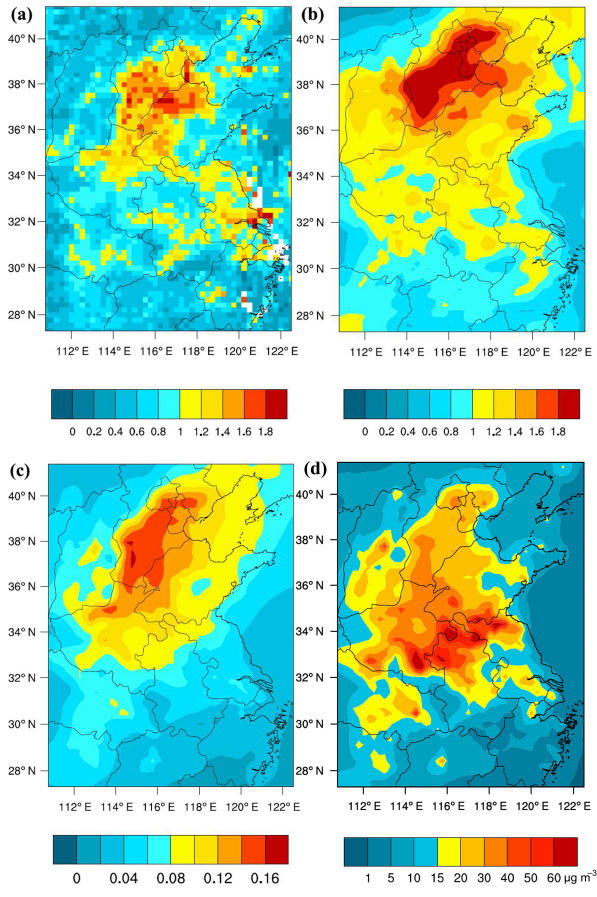
Figure 5. Spatial distribution of mean (a) 550nm aerosol opti- cal depth observations from MODIS, (b) 550nm aerosol optical depth from WRF-Chem, (c) mean absorption aerosol optical depth from WRF-Chem and (d) mean carbonaceous aerosol concentration (µgm − 3 ) at the lowest model level ( ∼ 20m) during the summer har- vest (1–21 June). BASE run is shown.